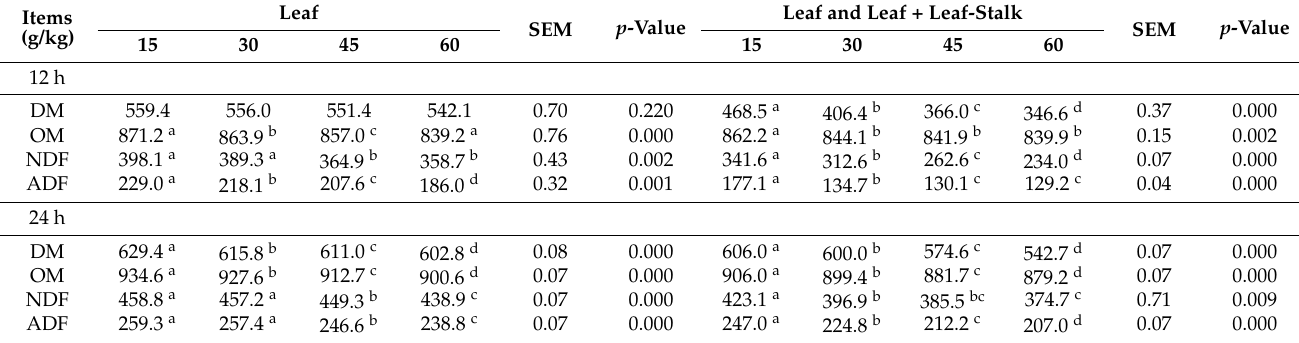
Table 3. In vitro nutrient degradability in leaf and leaf + leaf-stalk of Brazilian spinach at 15, 30, 45 and 60 days of harvesting. Items